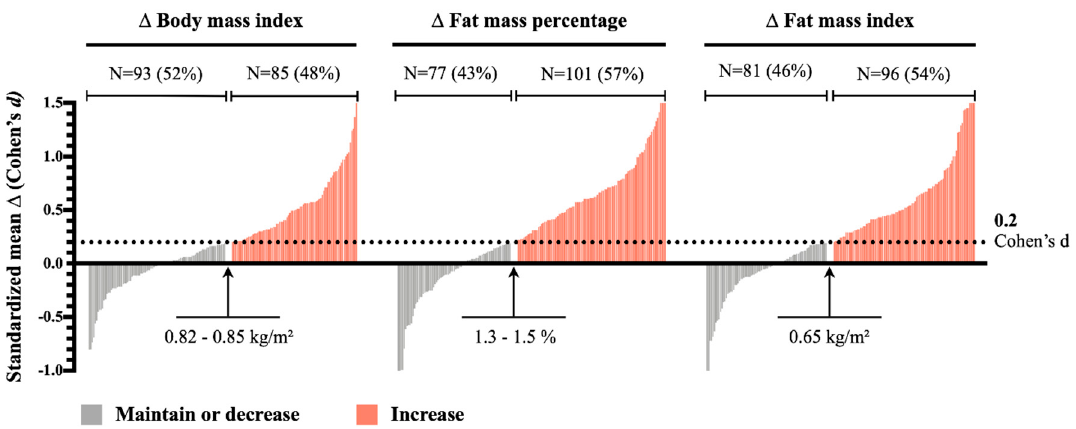
baseline. The mean change of adiposity was higher than zero (which indicates an increase)